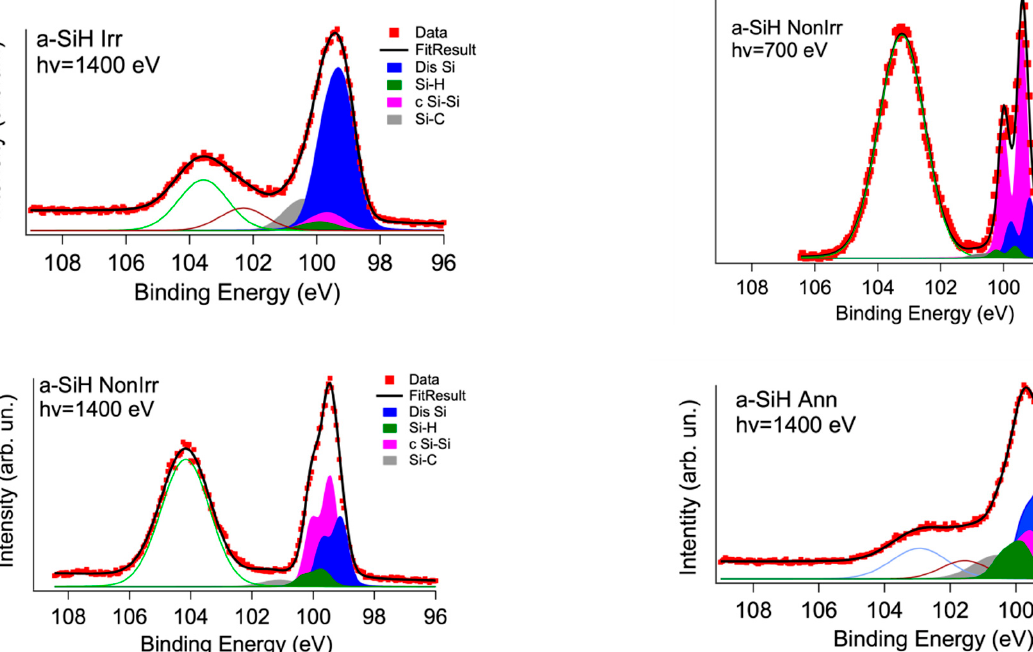
Figure 4. Si2p core level deconvolution for a-Si:H device samples measured in different samples: top left non-irradiated hv = 1400 eV, right non-irradiated hv = 700 eV; bottom left irradiated, bottom right: irradiated and annealed.